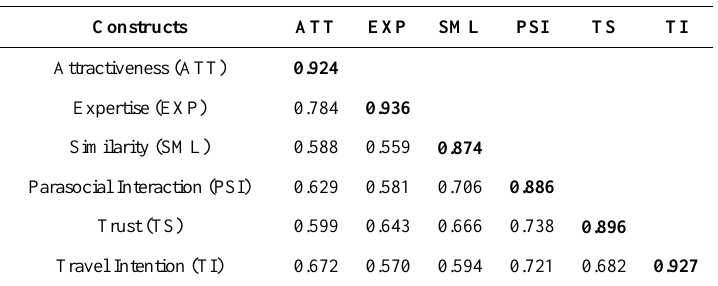
Table 5. Fornell-Larcker